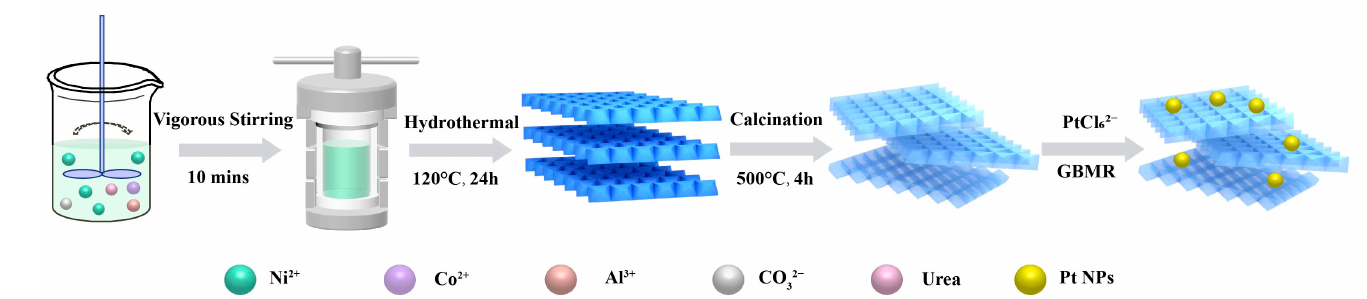
Figure 1. Schematic diagram of preparation for Pt n /Ni 1.5 Co 0.5 AlO catalysts.